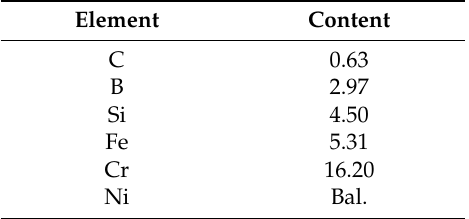
Table 1. Chemical composition of Ni60 powder (wt